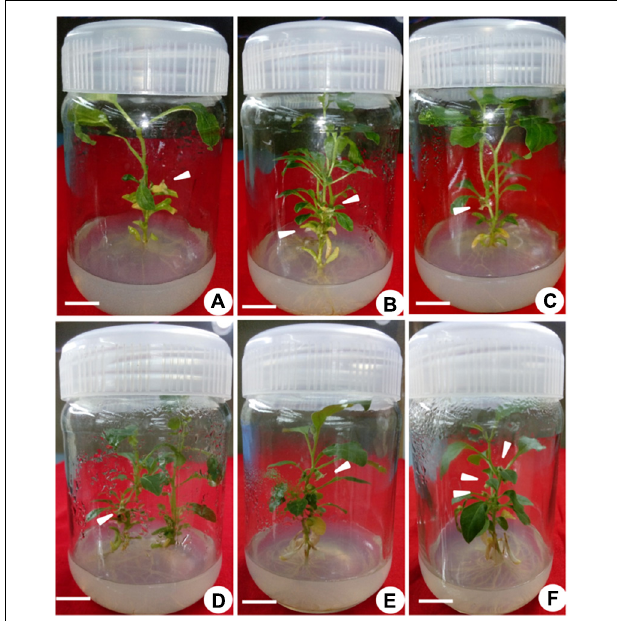
FIGURE 3 | In vitro flowering of Withania somnifera . (A) In vitro flower formation from second node (scale bar = 0.7 cm), (B) first and second nodes (scale bar = 0.6 and 0.5 cm); (C,D) second node (scale bar = 0.6 and 0.4 cm), (E) sixth node (scale bar = 0.5 cm), and (F) third, fourth, and fifth nodes (scale bar = 0.4, 0.3, and 0.7 cm).